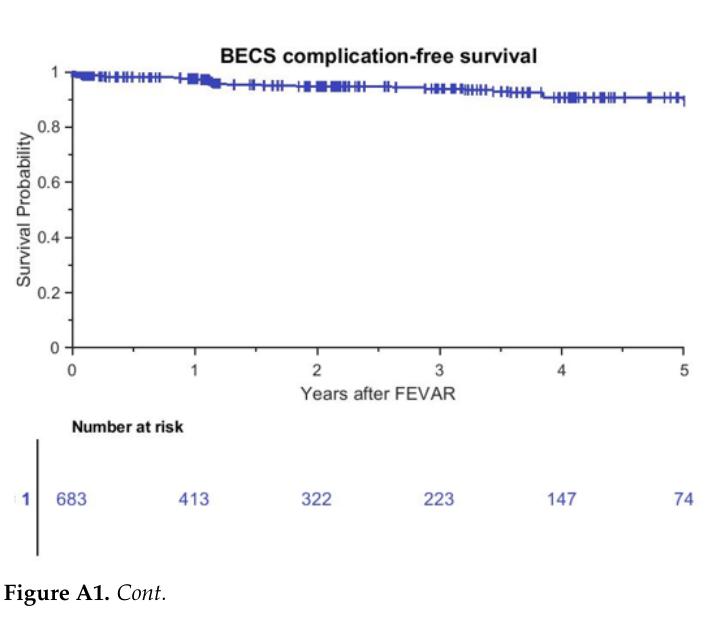
Figure A1. Kaplan–Meier curves for freedom from Advanta V12 balloon ‐ expandable covered stent (BECS) ‐ associated complication and reintervention. FEVAR, fenestrated endovascular aneurysm re ‐ pair. References 1.